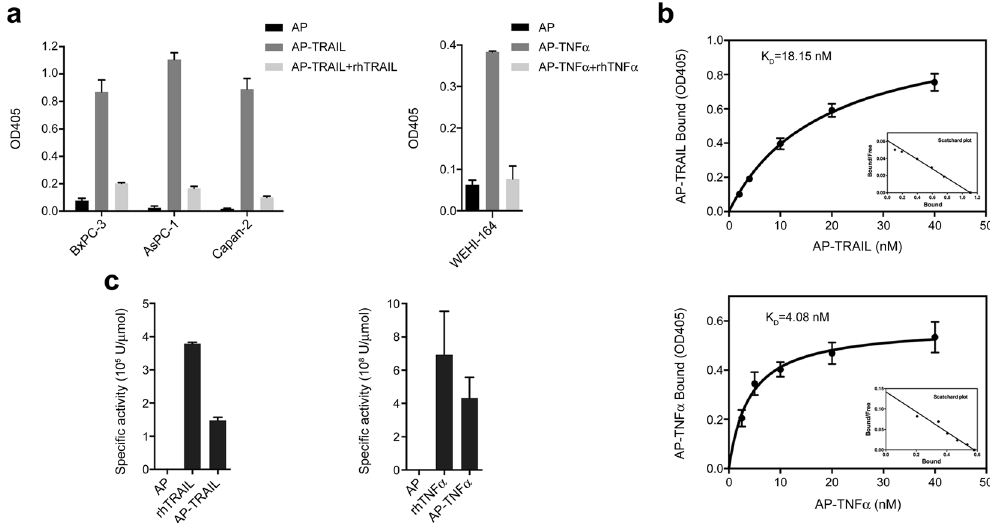
Figure 2. Cell surface receptor binding of alkaline phosphatase (AP)-tagged TNFSF ligands. ( a ) Detection of cell surface receptor(s) from either cultured human pancreatic cancer cell lines (BxPC-3, AsPC-1, and Capan- 2) with AP-TRAIL (left) or WEHI- 164 cells with AP-TNF α (right). AP alone served as a negative control, while 100-fold excess of unlabeled rhTRAIL or rhTNF α served as controls for receptor binding specificity. ( b ) Saturation binding kinetics of AP-TRAIL to BxPC-3 cells (top) and AP-TNF α to WEHI-164 cells (bottom) were determined with increasing concentration of the AP-tagged ligands. The data presented as Scatchard plots were shown as insets in the bottom right of saturation binding curves. ( c ) Analysis of the biological activities AP- tagged TRAIL and TNF α in comparison to untagged ligands by bioassays using TRAIL-sensitive BxPC-3 and TNF α -sensitive WEHI-164 cells, respectively as described